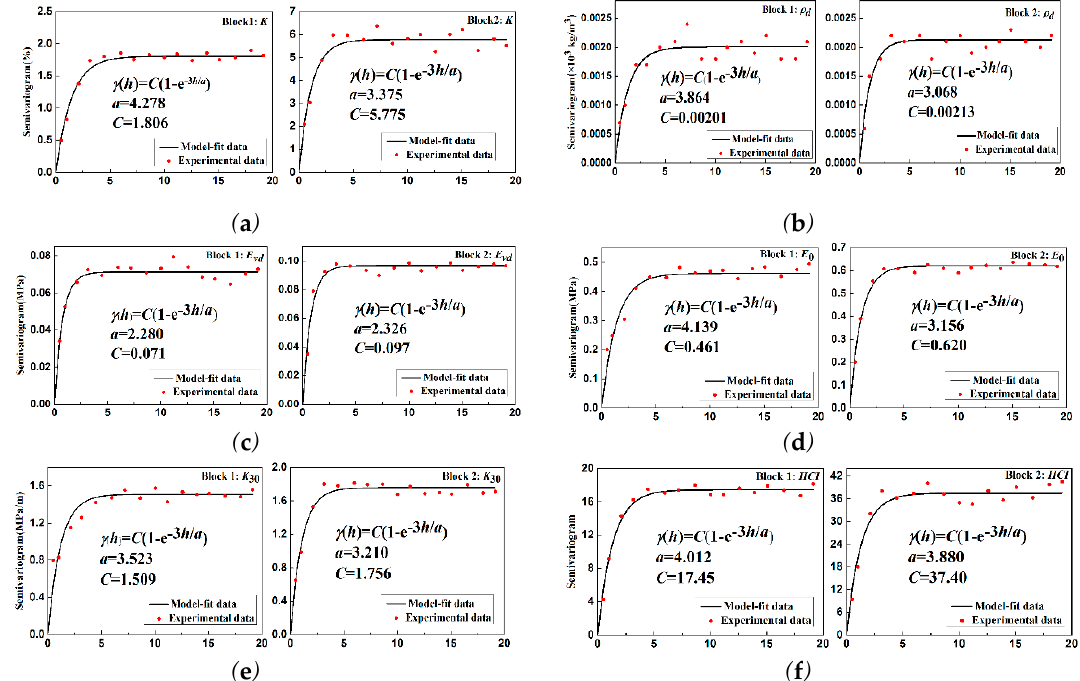
Figure 9. Semivariogram of evaluation indices of each block: ( a – e ) the physical and mechanical indices; ( f ) the hybrid index HCI .